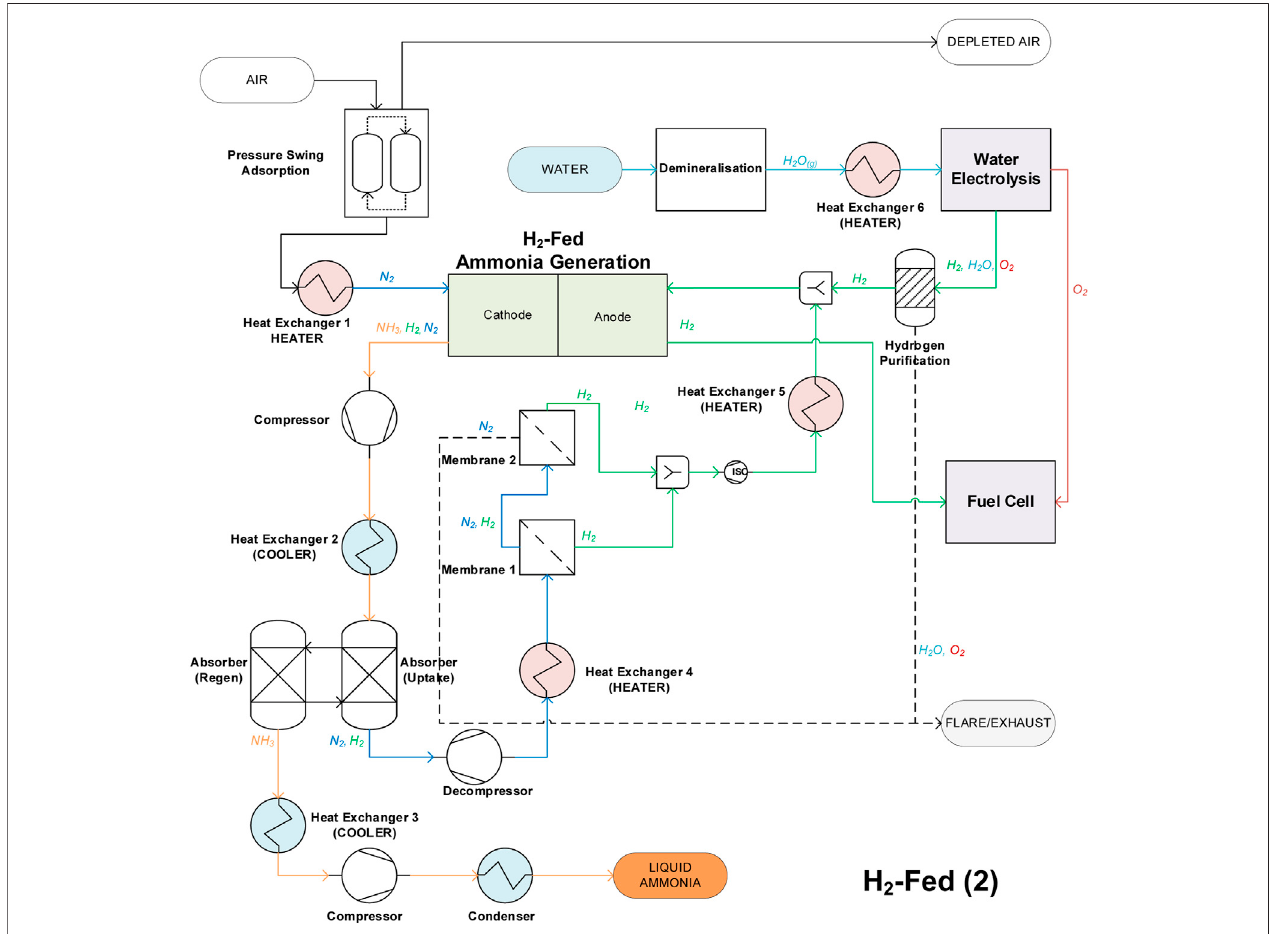
FIGURE 4 | Hydrogen-fed process fl ow arrangement [H 2 -fed (2)] without anode hydrogen recovery.